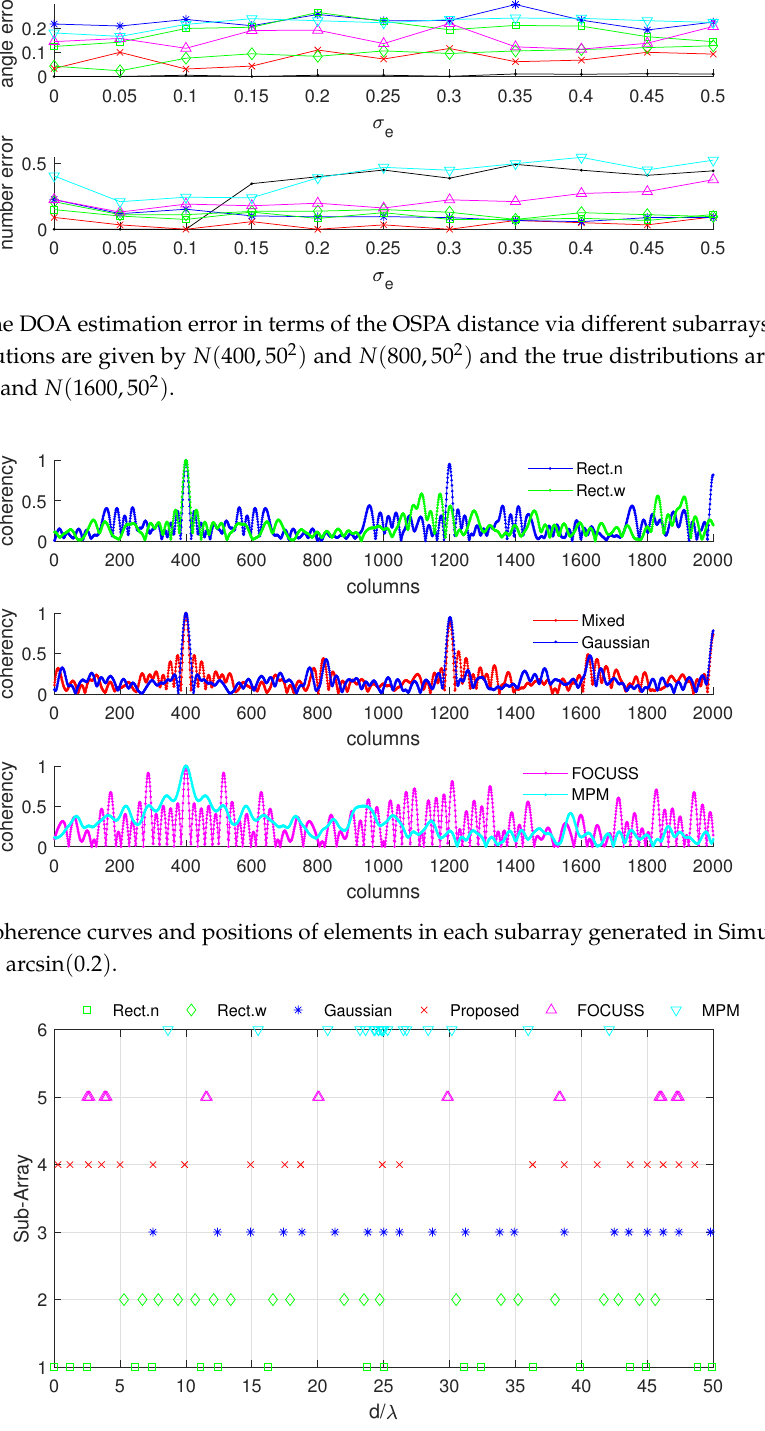
Figure 14. Positions of elements in each subarray generated in Simulation